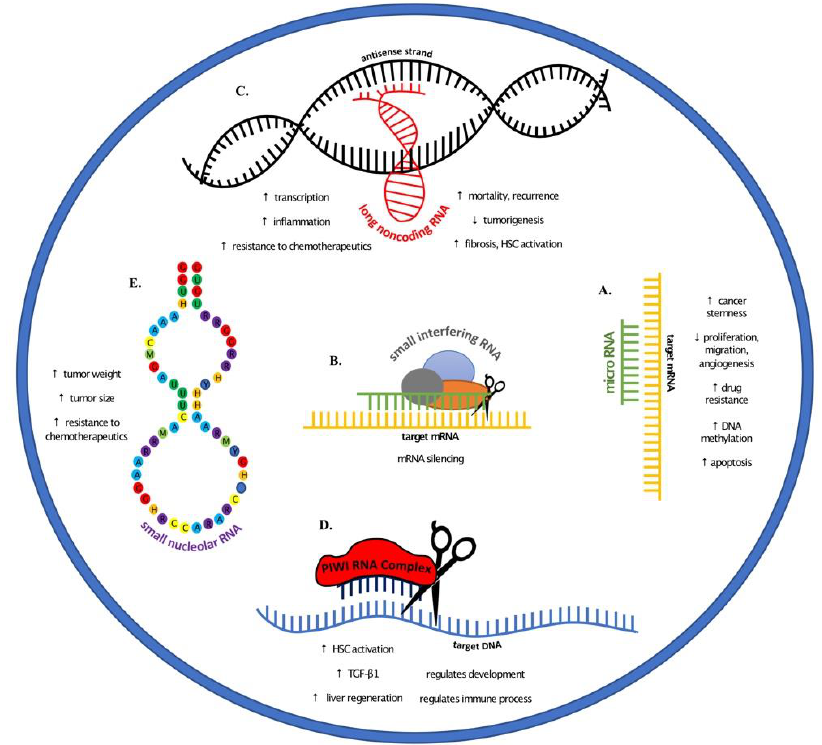
Figure 1. Noncoding RNAs and their roles in liver cancer elucidated through various animal models. ( A ) microRNAs regulate cancer progression through increasing stemness, drug resistance, and DNA methylation. Conversely, microRNAs play a role in decreased proliferation, migration, and angiogenesis, and increased apoptosis. ( B ) Small interfering RNAs target messenger RNA and silence their transcription. ( C ) The role of long noncoding RNA (lncRNA) varies with increased transcription, inflammation, resistance to chemotherapeutics, and fibrosis. In addition to increased HSC activation, there are higher incidence of mortality and cancer recurrence. Other lncRNAs have also been indicated in decreased tumorigenesis. ( D ) PIWI RNA have been shown to activate HSCs and increase TGF- β 1 expression and liver regeneration, in addition to regulating immune processes and development. ( E ) Small nucleolar RNAs provide resistance to chemotherapeutic drugs and have been shown to increase tumor size and weight.